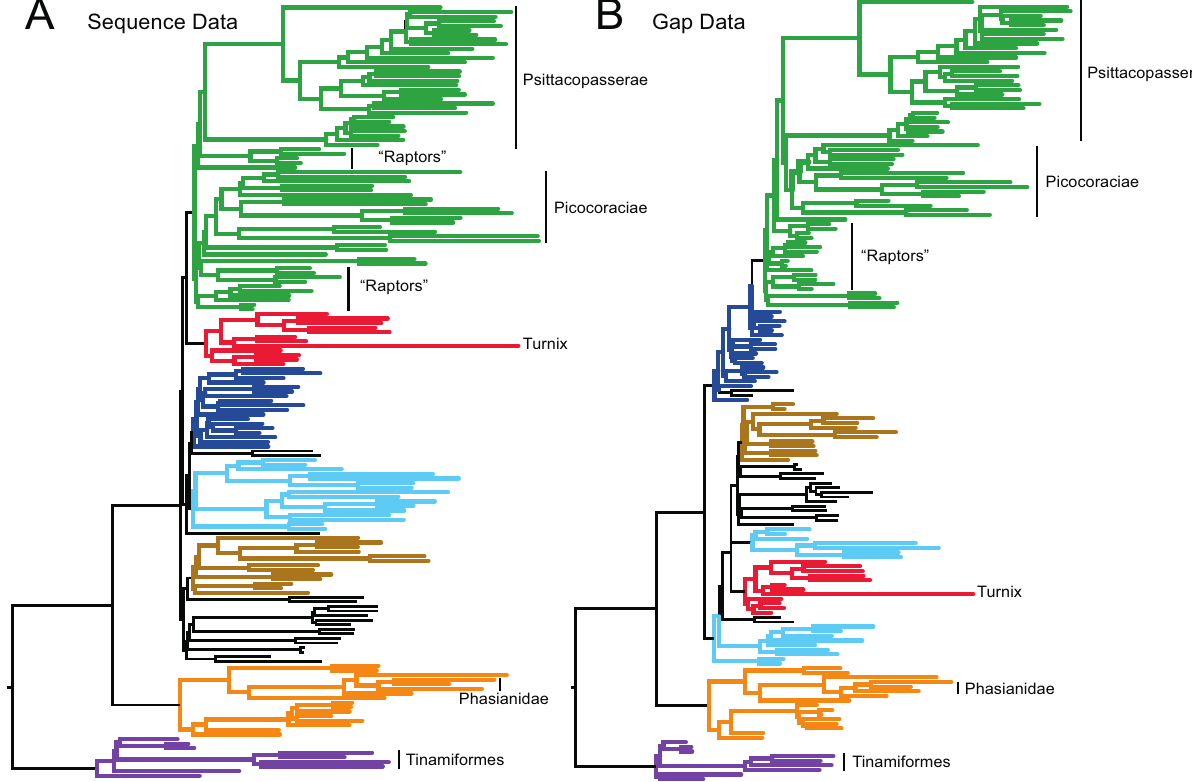
Figure 4. Branch length heterogeneity evident in the ( a ) optimal nucleotide tree (based upon the (cid:42)(cid:55)(cid:53)(cid:14)(cid:44)(cid:14)(cid:299)(cid:3)(cid:80)(cid:82)(cid:71)(cid:72)(cid:79)(cid:12) and ( b ) the optimal gap tree (based upon the (cid:38)(cid:41)(cid:49)(cid:89)(cid:14)(cid:299)(cid:3)(cid:80)(cid:82)(cid:71)(cid:72)(cid:79)(cid:12)